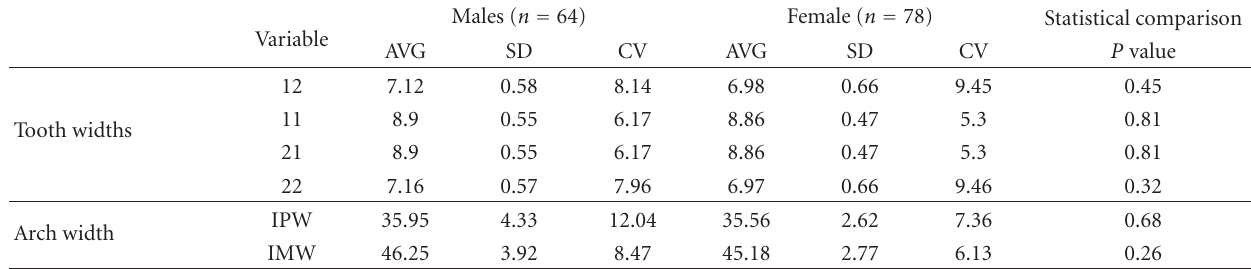
Table 1: Tooth size and dental arch width (in mm) for males and females described in terms of arithmetic means (AVG), standard deviation (SD), and coe ffi cient of variation (CV). Males ( n = 64) Variable